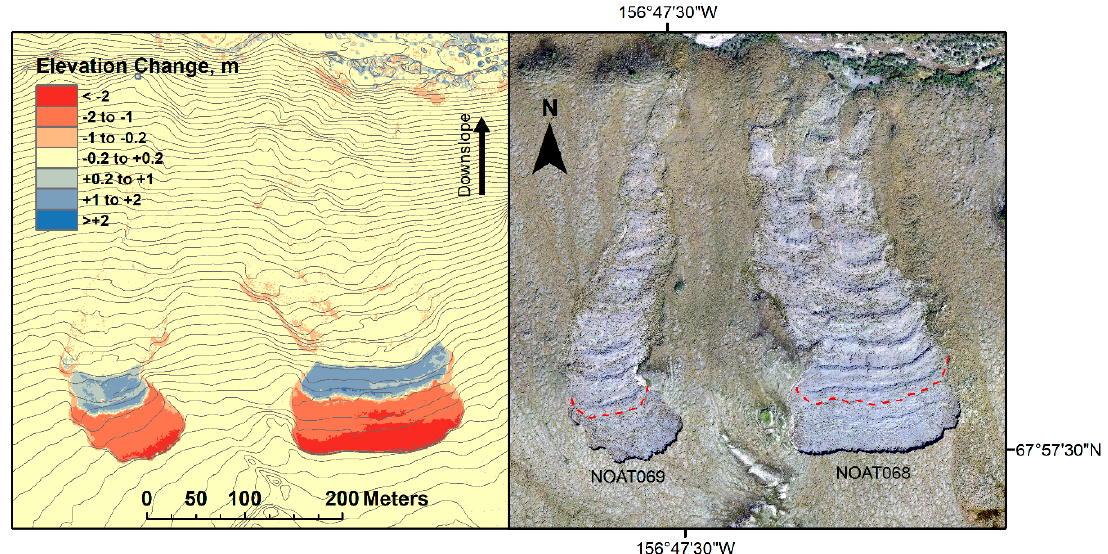
Figure 1. Retrogressive thaw slumps (RTS) in the Noatak National Preserve, Alaska. The contour map on the left (1 m contour interval), a result of this study, shows elevations in 2016 and the elevation change from 16 September 2013 to 11 July 2016. The orthophotograph on the right is from 2016, with the 2013 scarp position noted as a dashed red line. The volume changes in the upper subsidence zone (red, − ) and nearby deposition zone (blue, +) were, for slump NOAT068: − 19,216 m 3 and +5959 m 3 (31% of the subsidence volume); and for slump NOAT069: − 7759 m 3 and +2623 m 3 (34% of the subsidence volume).